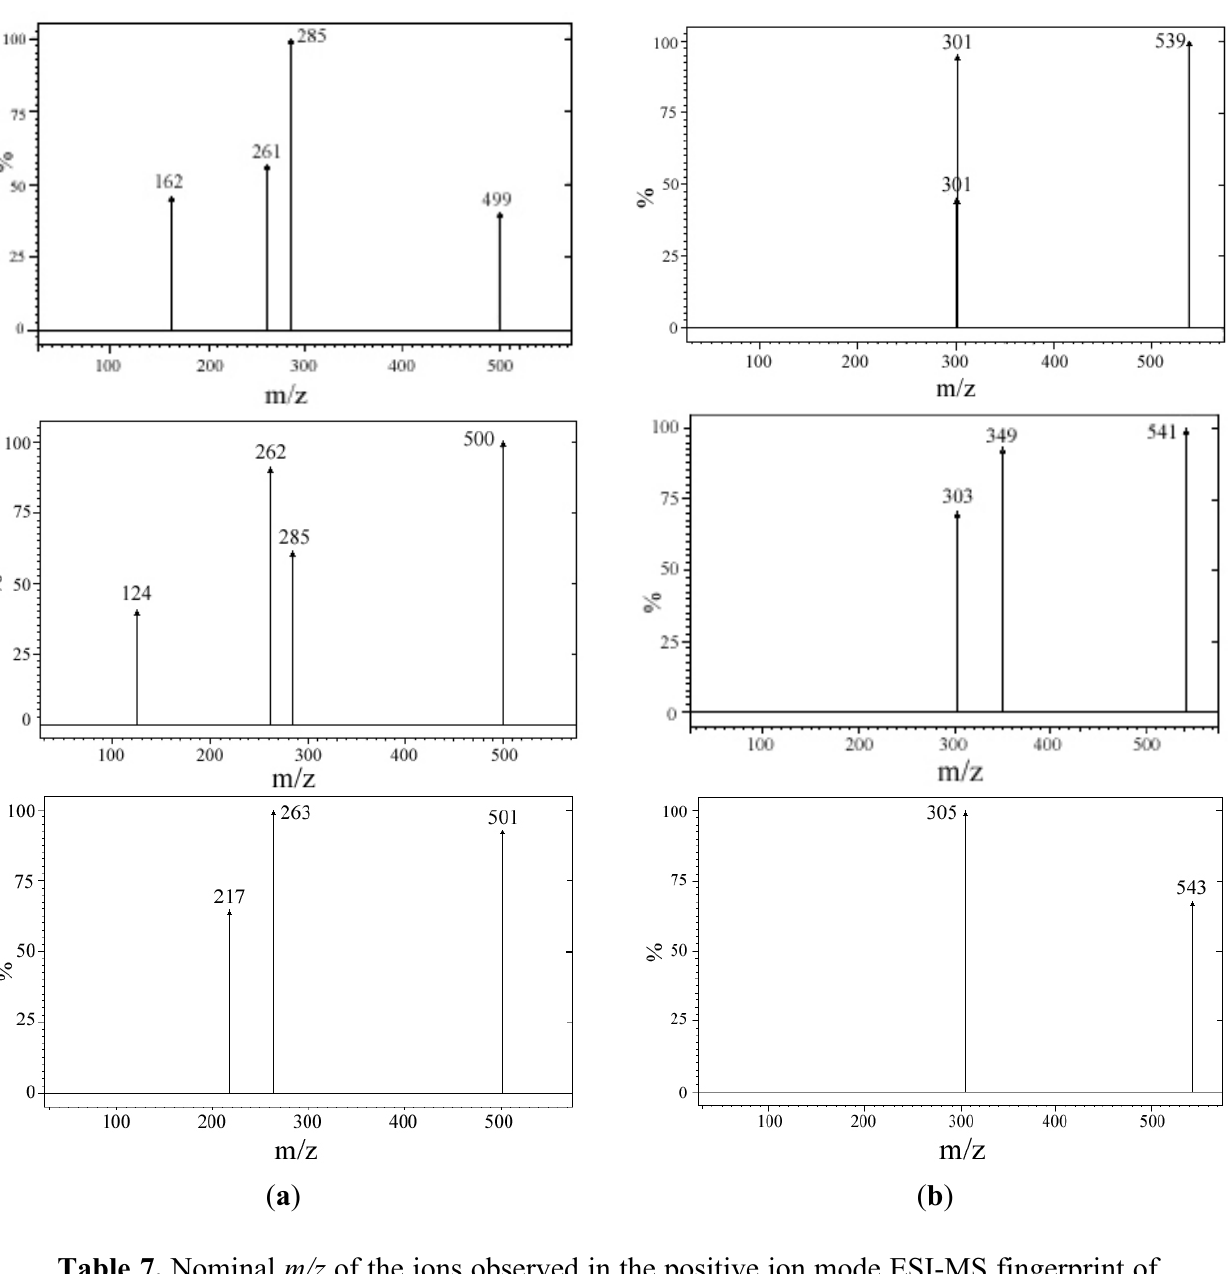
Table 7. Nominal m/z of the ions observed in the positive ion mode ESI-MS fingerprint of the complexes and the identified